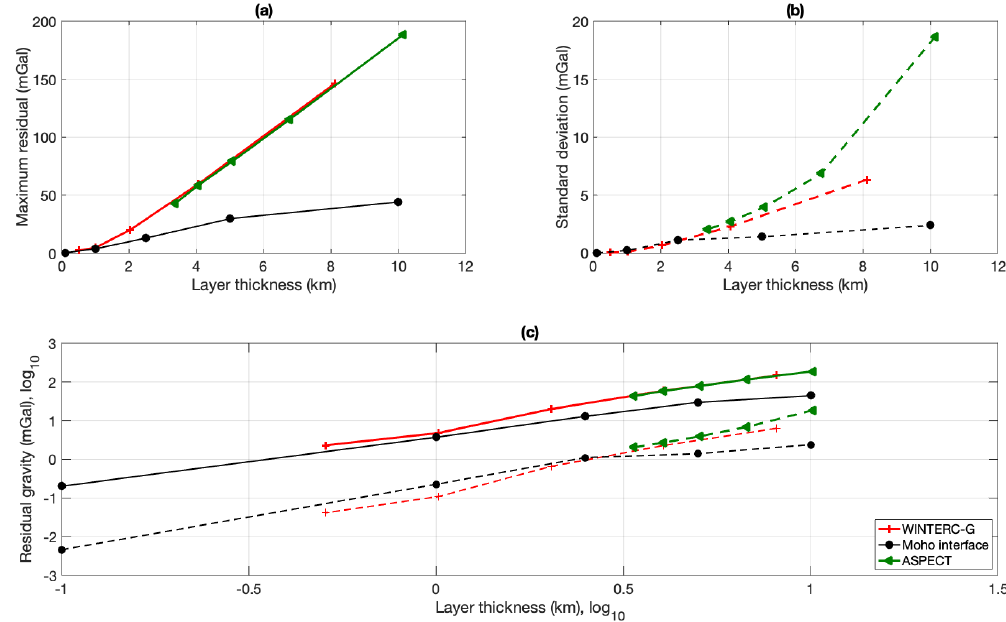
Figure 10. (a) Maximum gravity error for the equal layered model versus the geometrically bounded model for the simple 80km crust– mantle model (black with circle marker) and the full WINTERC-G model by GSH (red with plus marker) and ASPECT (green with triangle marker). (b) Similar to (a) , but the standard deviation of the residuals is plotted. (c) Maximum (solid lines) and standard deviation (dashed lines) residuals but plotted on a logarithmic